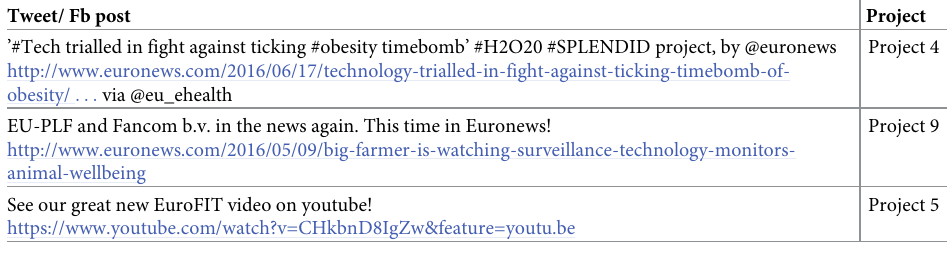
Table 9. Examples of tweets and Facebook posts with qualitative evidence of social impact. Tweet/ Fb